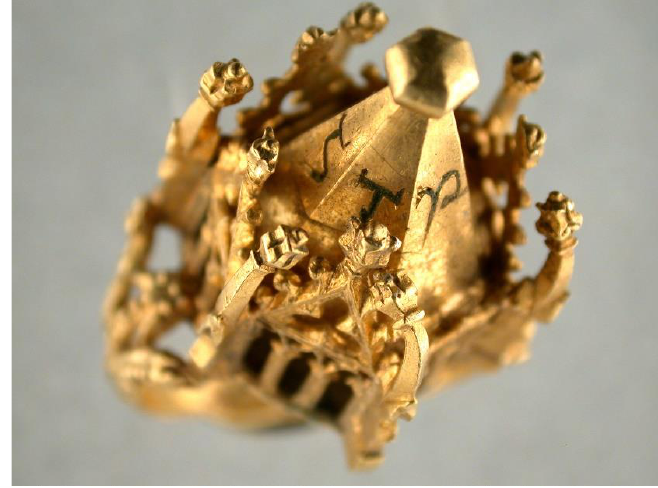
Figure 4. Bezel. Figure 4. Jewish Wedding Ring, Erfurt Treasure (first half of 14th Century), © B. Stefan, Thuringian State Office for Heritage Management and Archaeology.